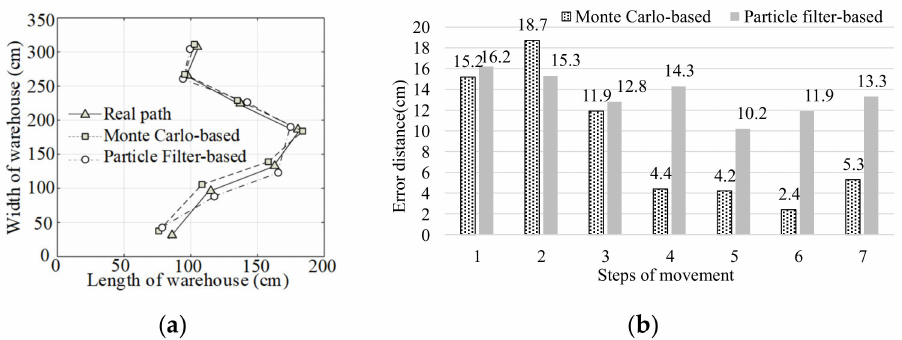
Figure 11. Experimental positioning results ( a ) and positioning errors ( b ) when the dual-antenna RFID positioning system has two separated footprints.